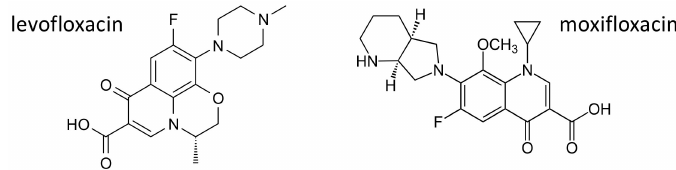
Figure 7. Chemical structures of the fluoroquinolones levofloxacin and